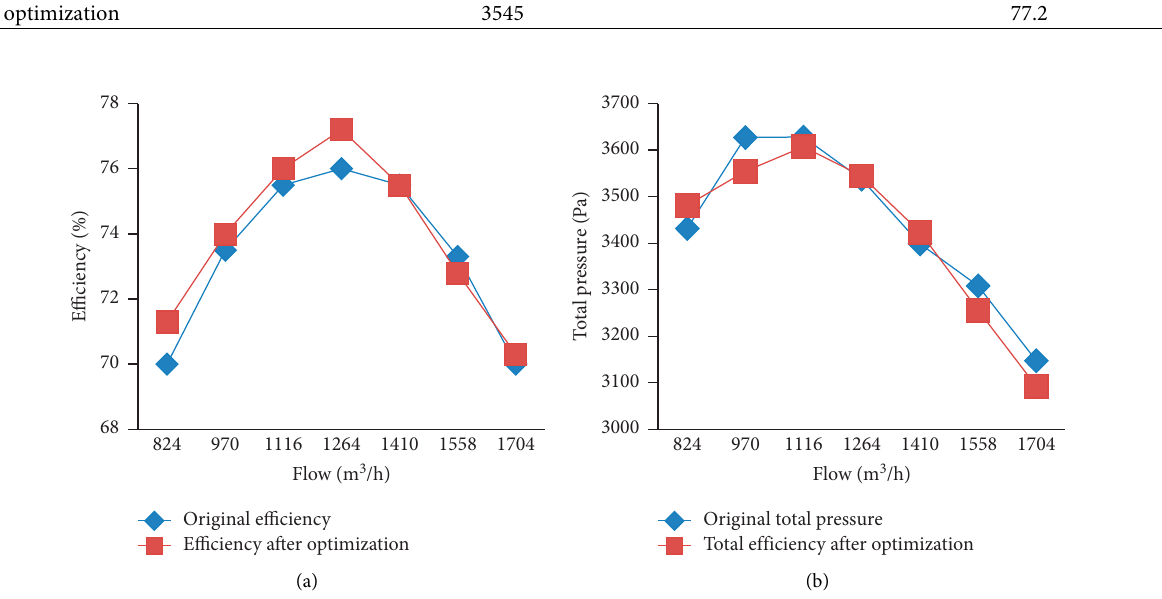
Figure 11: Performance curve before and after optimization: (a) efciency and (b) total pressure.